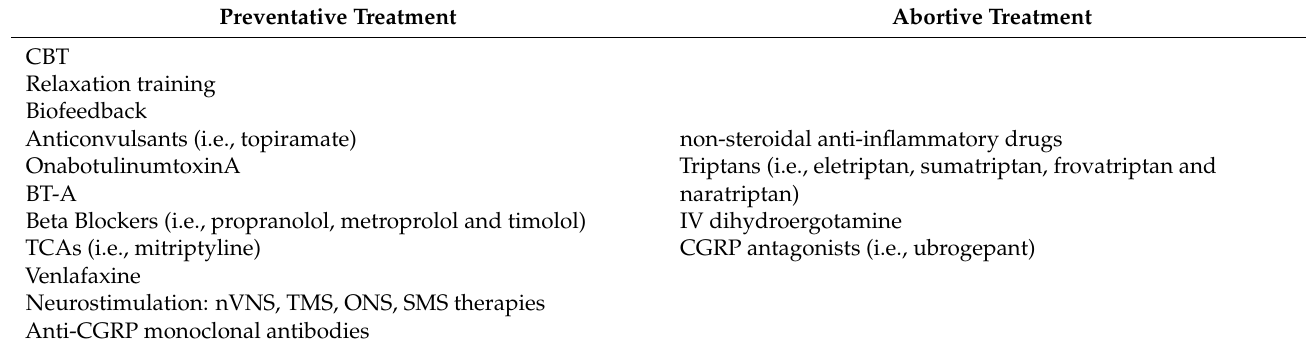
Table 1. Current Treatments in